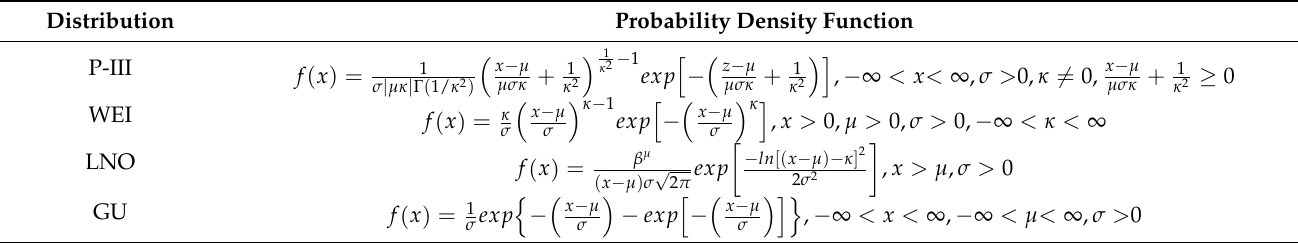
Table 3. Probability density functions of the alternative distributions.